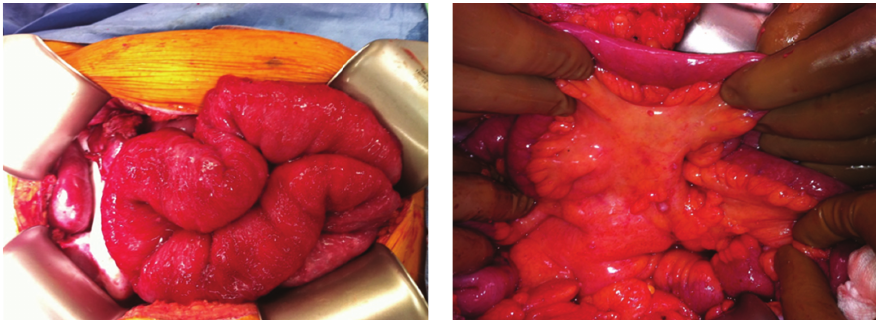
Figure 2: Mesenteric disease from gastric cancer primary leading to bowel